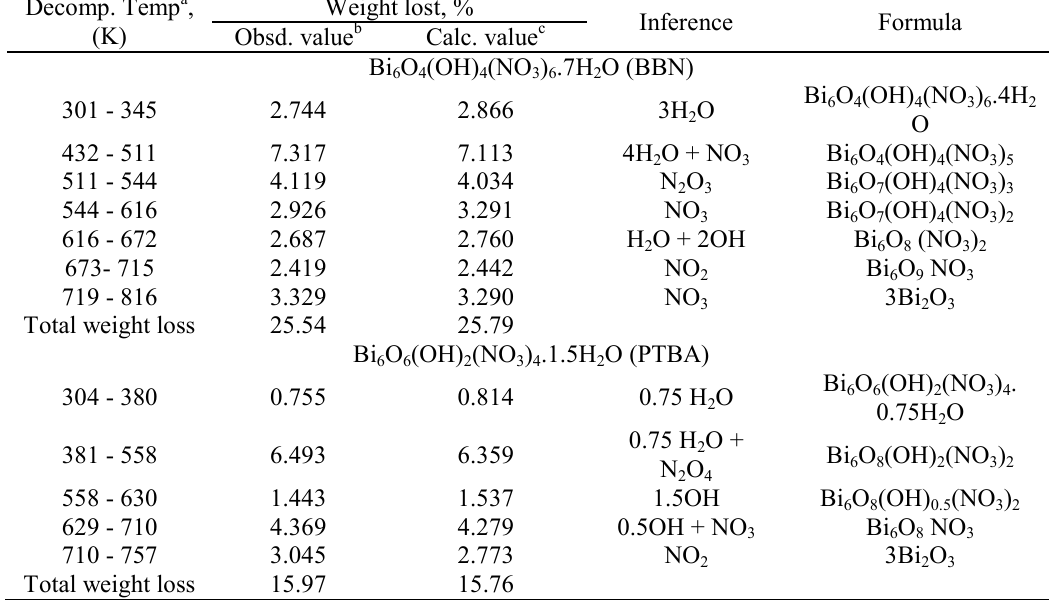
Table 1 . Thermal decomposition stages of suggested formula of BBN and PTBA sorbents. Decomp. Temp a ,